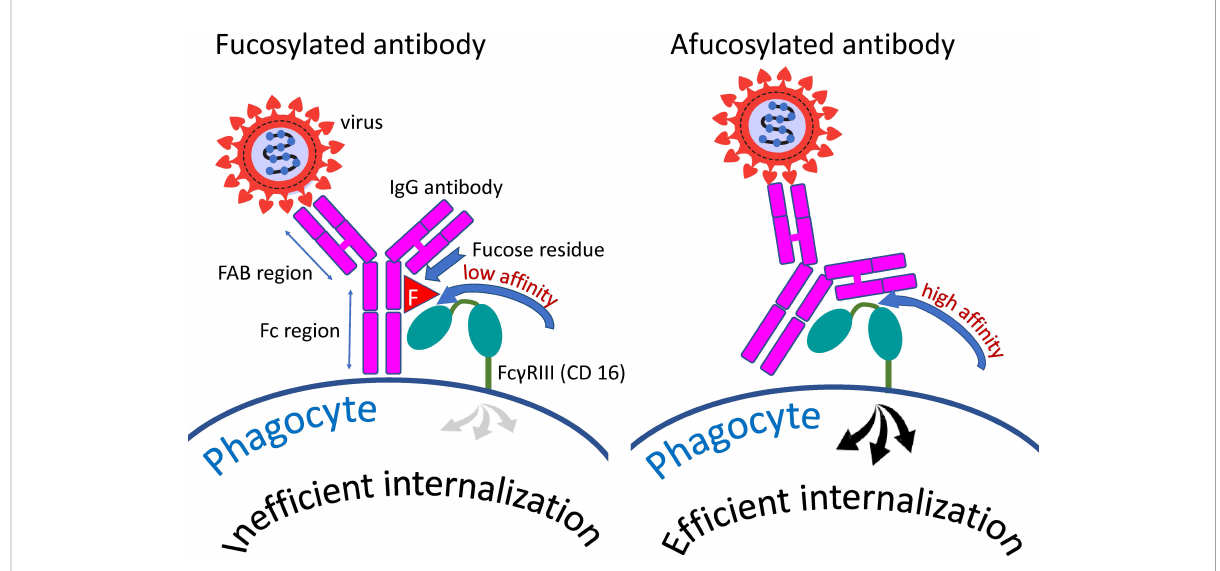
FIGURE 3 Distinction between fucosylated and afucosylated antibodies. Fucosylated antibodies have a lower af fi nity for the cellular receptor Fc g RIIIa (CD16a) compared to afucosylated antibodies. Consequently, these antibodies contribute less to the internalization of the pathogen by cells possessing this receptor than do afucosylated